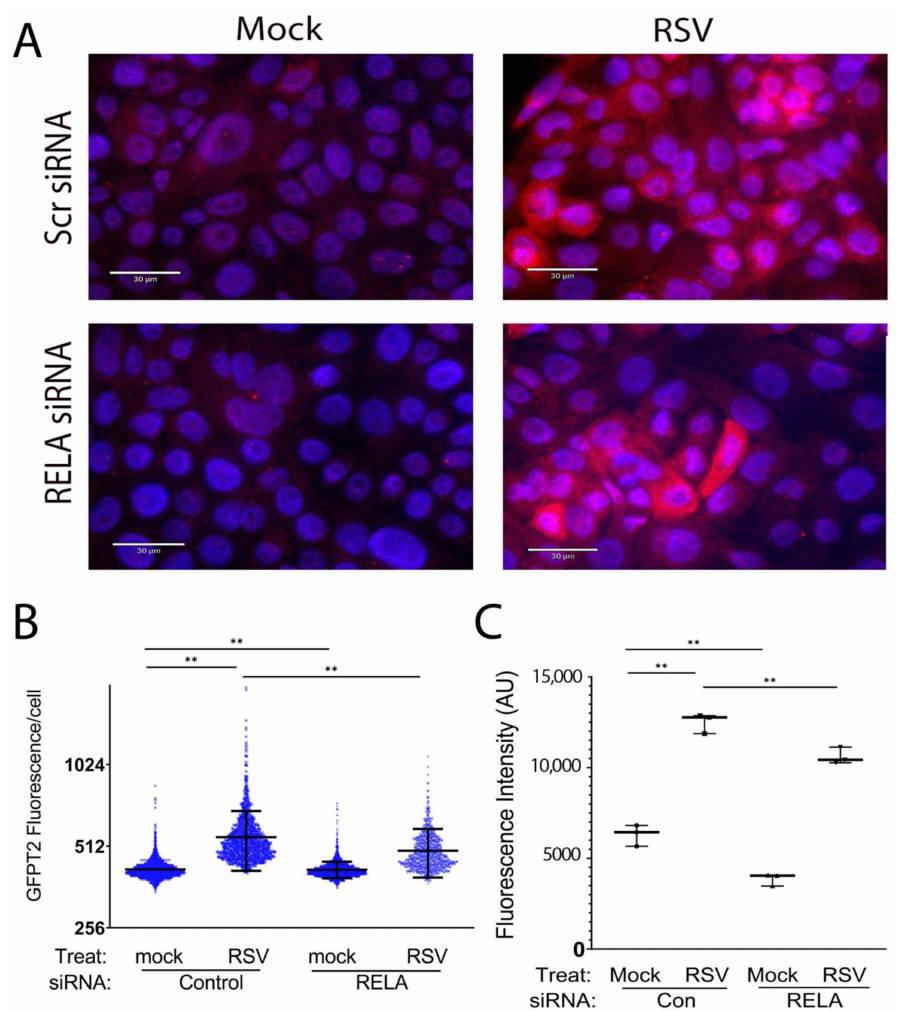
Figure 4. Role of RELA in cytoplasmic GFPT2 expression. ( A ) Scr or RELA siRNA-transfected hSAECs were mock-infected or RSV-infected. Cells were permeabilized and stained with anti- GFPT2 Ab (red). Nuclear stained is by DAPI (blue). Bar indicates 30 µ m. ( B ) The quantitation of GFPT2 staining by FIJI. GFPT2 fluorescence was segmented by StarDist and plotted as arbitrary fluorescence/cell for each treatment condition. **, p < 0.01 by post-hoc Tukey comparison. ( C ) Flow cytometric quantification of GFPT2. GFPT2 fluorescence intensity was measured by flow cytometry. **, p < 0.01 by post-hoc Tukey